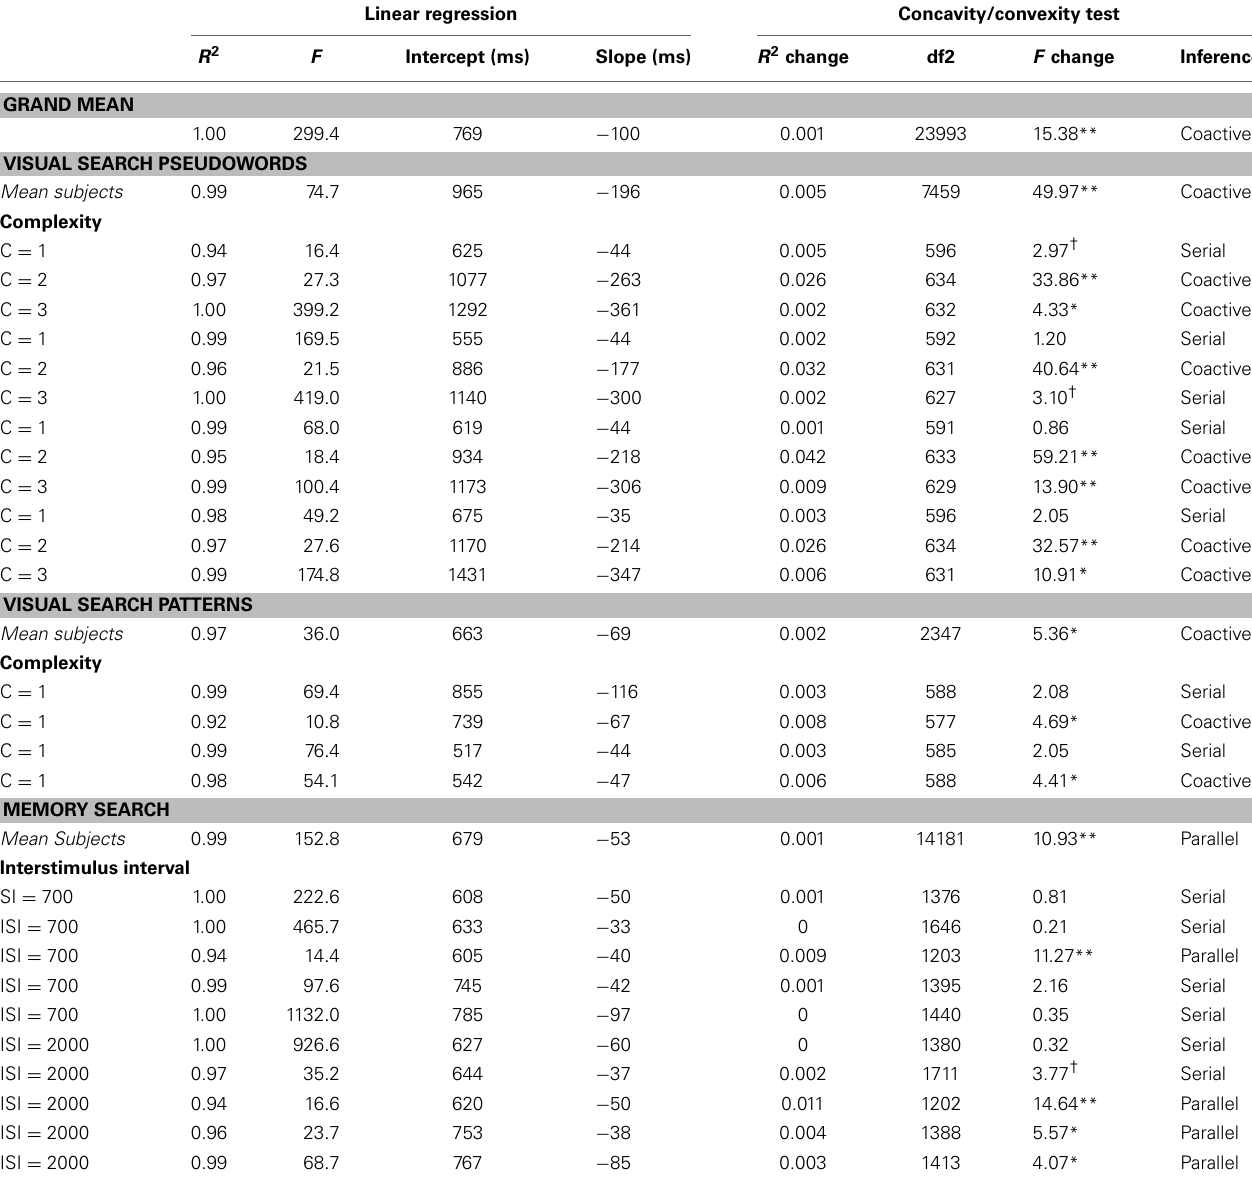
Table 4 | Summarized linear regression results for different levels of subject